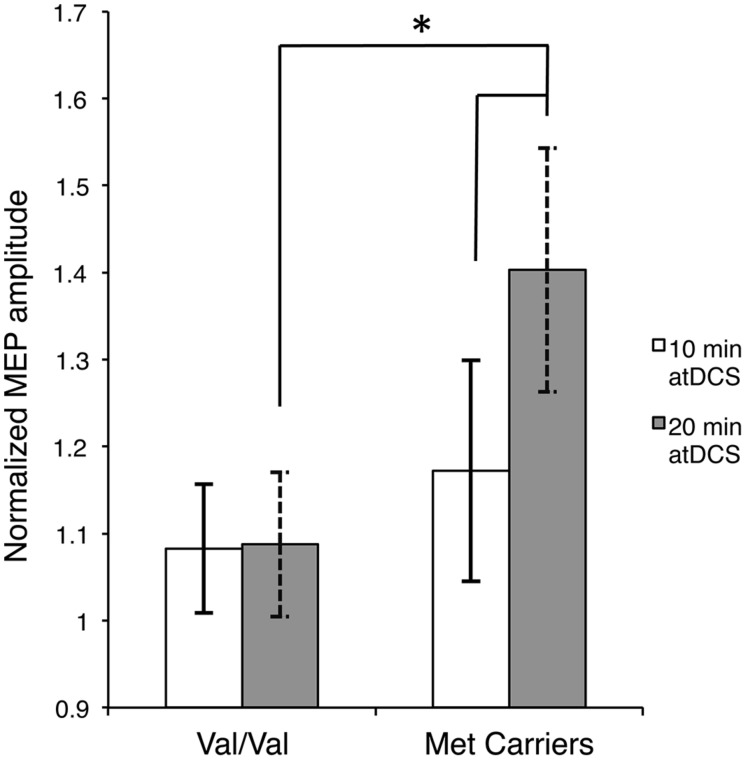
Stimulation duration and BDNF genotype dependent differences in post-atDCS response. Normalized MEP amplitude (ordinate), averaged over all post stimulation time points, in response to 10 min of atDCS (unfilled bars) and 20 min of atDCS (filled bars) plotted separately for each BDNF genotype (abscissa). nMEP > 1 represents facilitation, nMEP < 1 indicates suppression. Error bars display 95% confidence intervals around the mean and ∗p < 0.05.